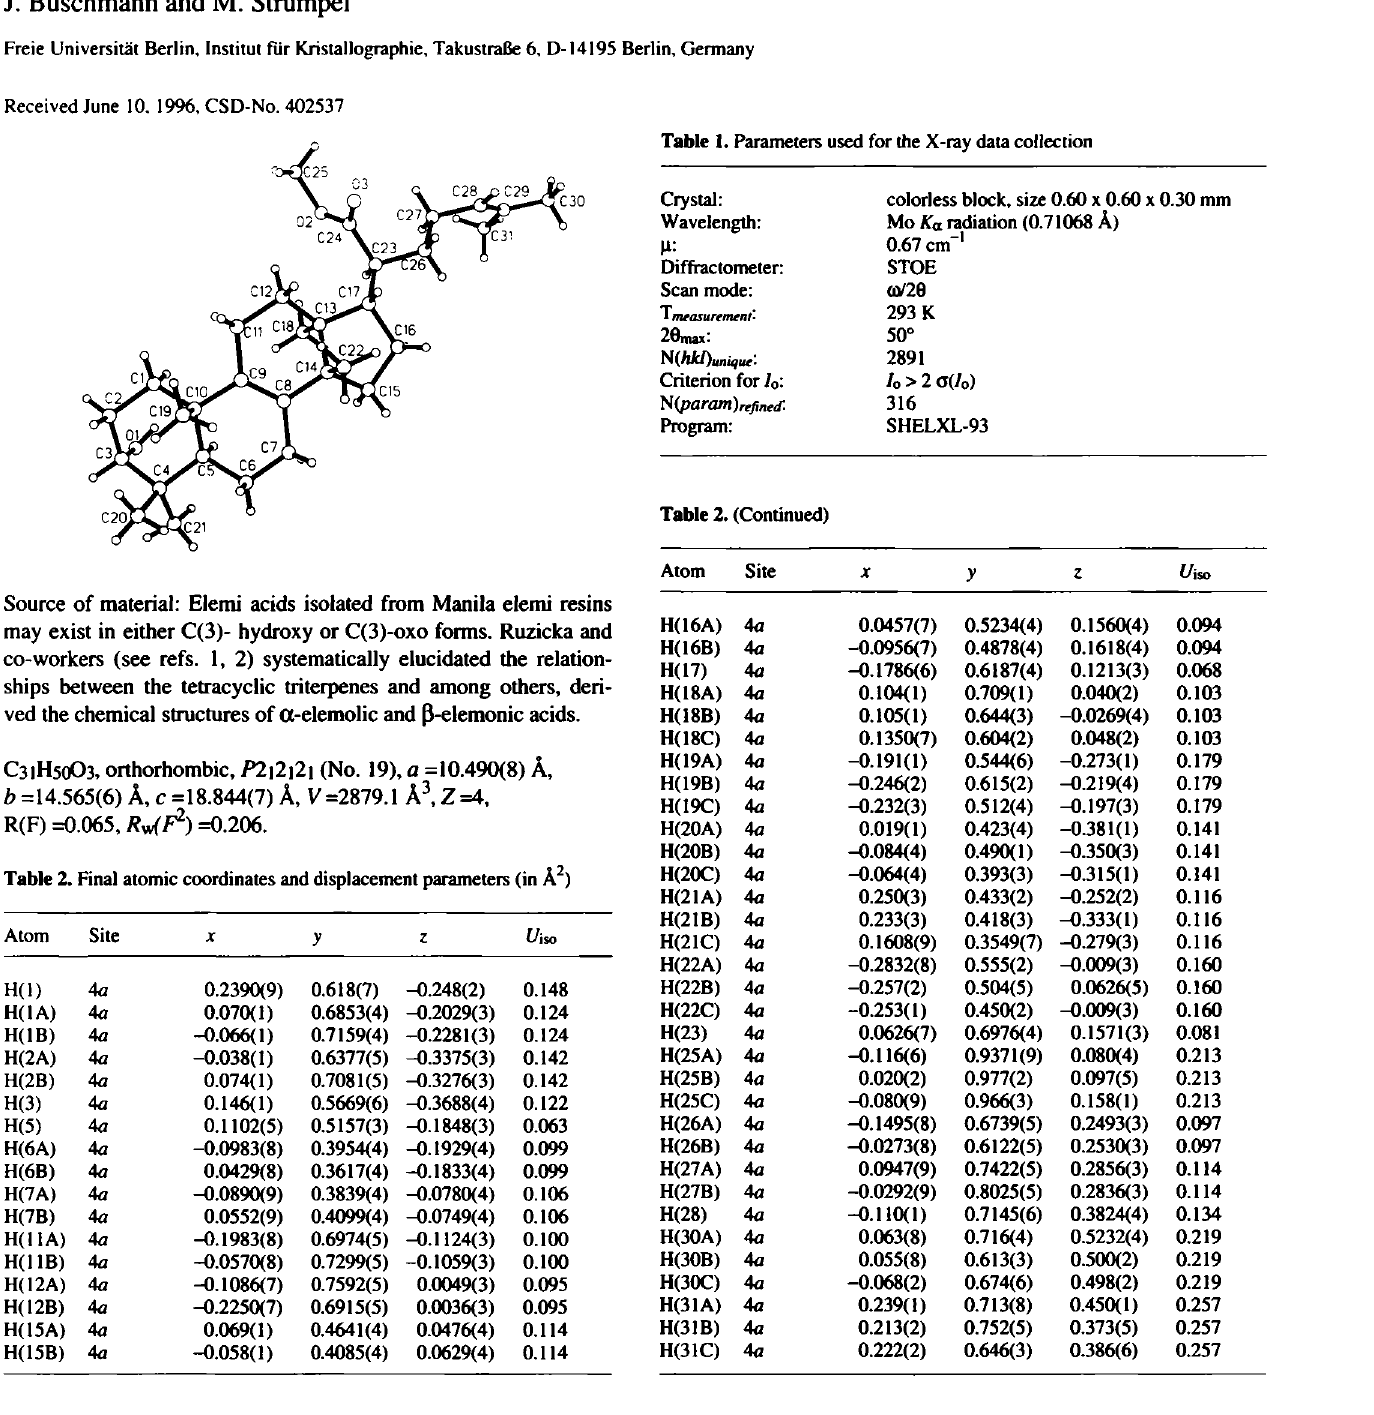
Table 1. Parameters used for the X-ray data collection